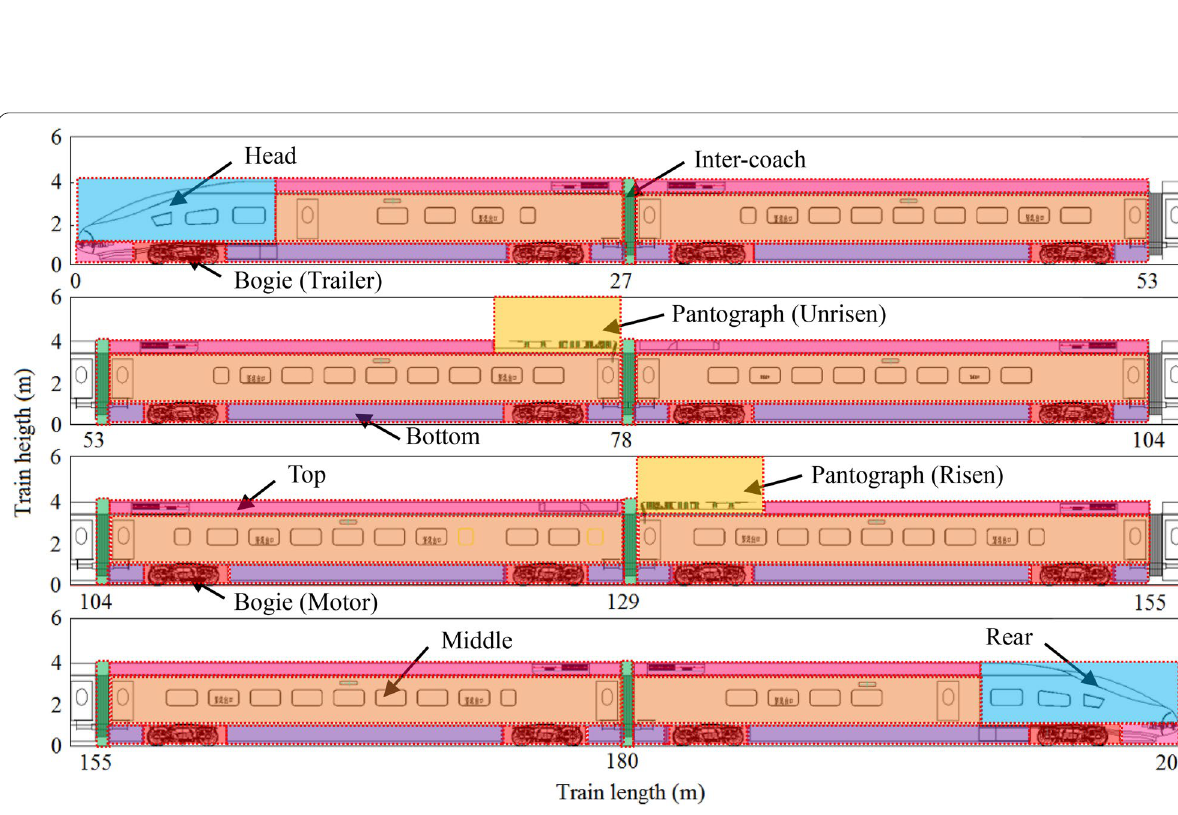
Figure 3 Different areas of the high-speed train